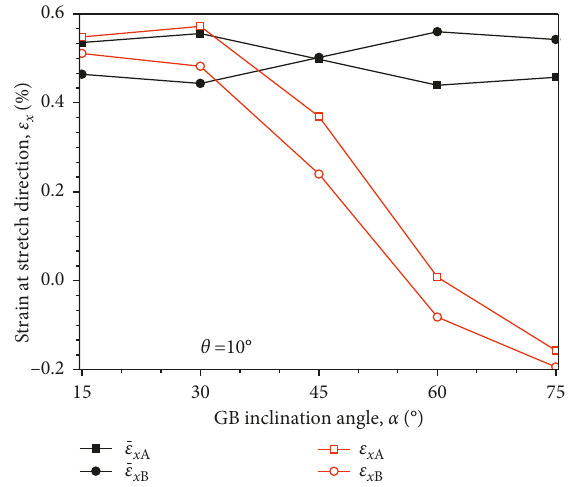
Figure 13: Strain state at the grain boundary and average strain of each grain for type II bicrystals.